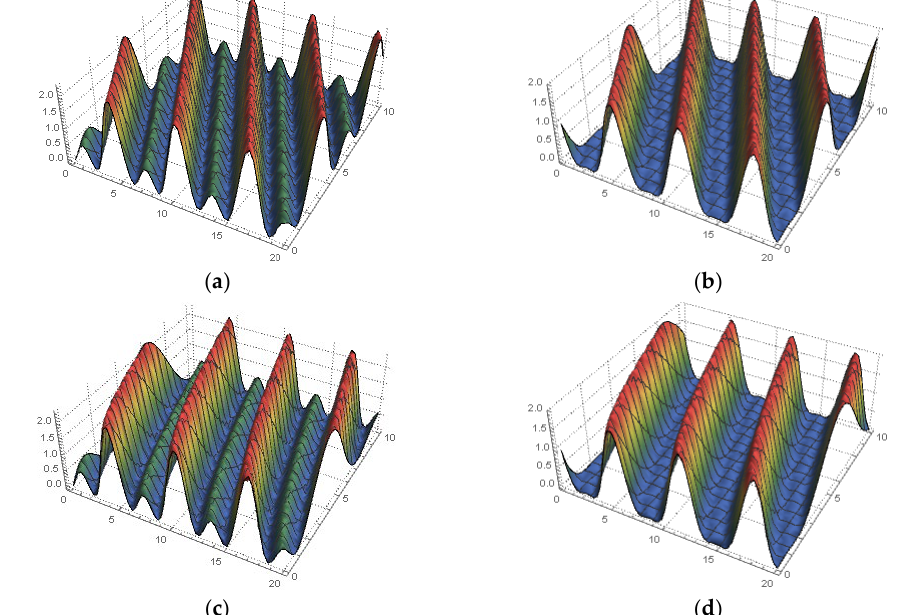
and with the parameters and for various values: ( a ) 2 2 | 𝐹𝐹 1 ( 𝑥𝑥 , 𝑑𝑑 )| | 𝐺𝐺 1 ( 𝑥𝑥 , 𝑑𝑑 )| 𝑟𝑟 1 = 𝑟𝑟 2 = 1, 𝑘𝑘 1 = 𝑘𝑘 2 = 𝜏𝜏 = 0 𝛼𝛼